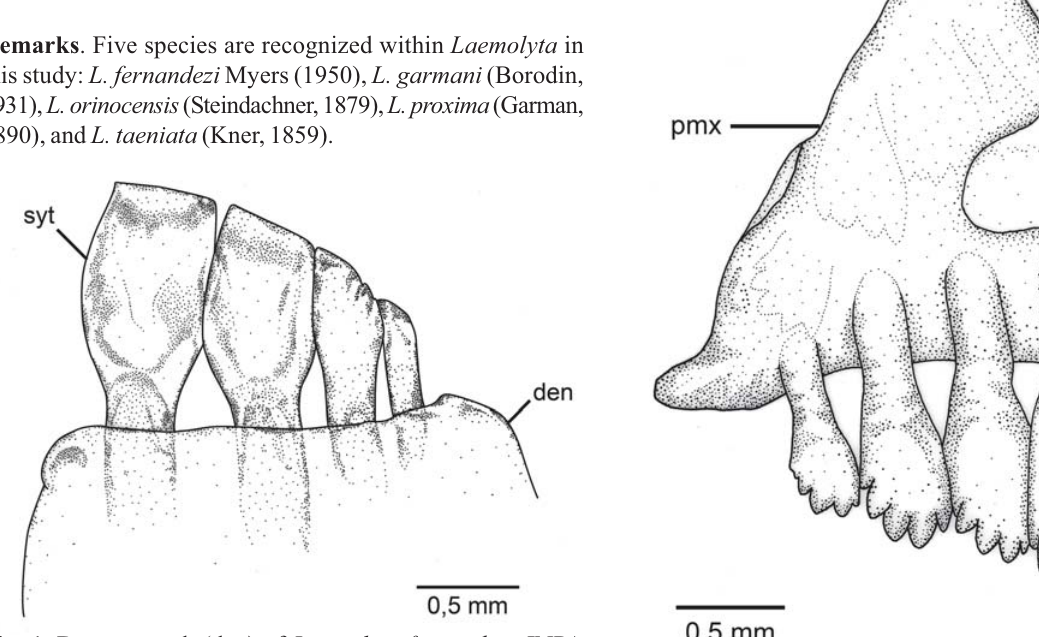
Fig. 1. Dentary teeth (den) of Laemolyta fernandezi , INPA 12234, 93.7 mm SL, left side, frontal view; syt = symphyseal tooth.